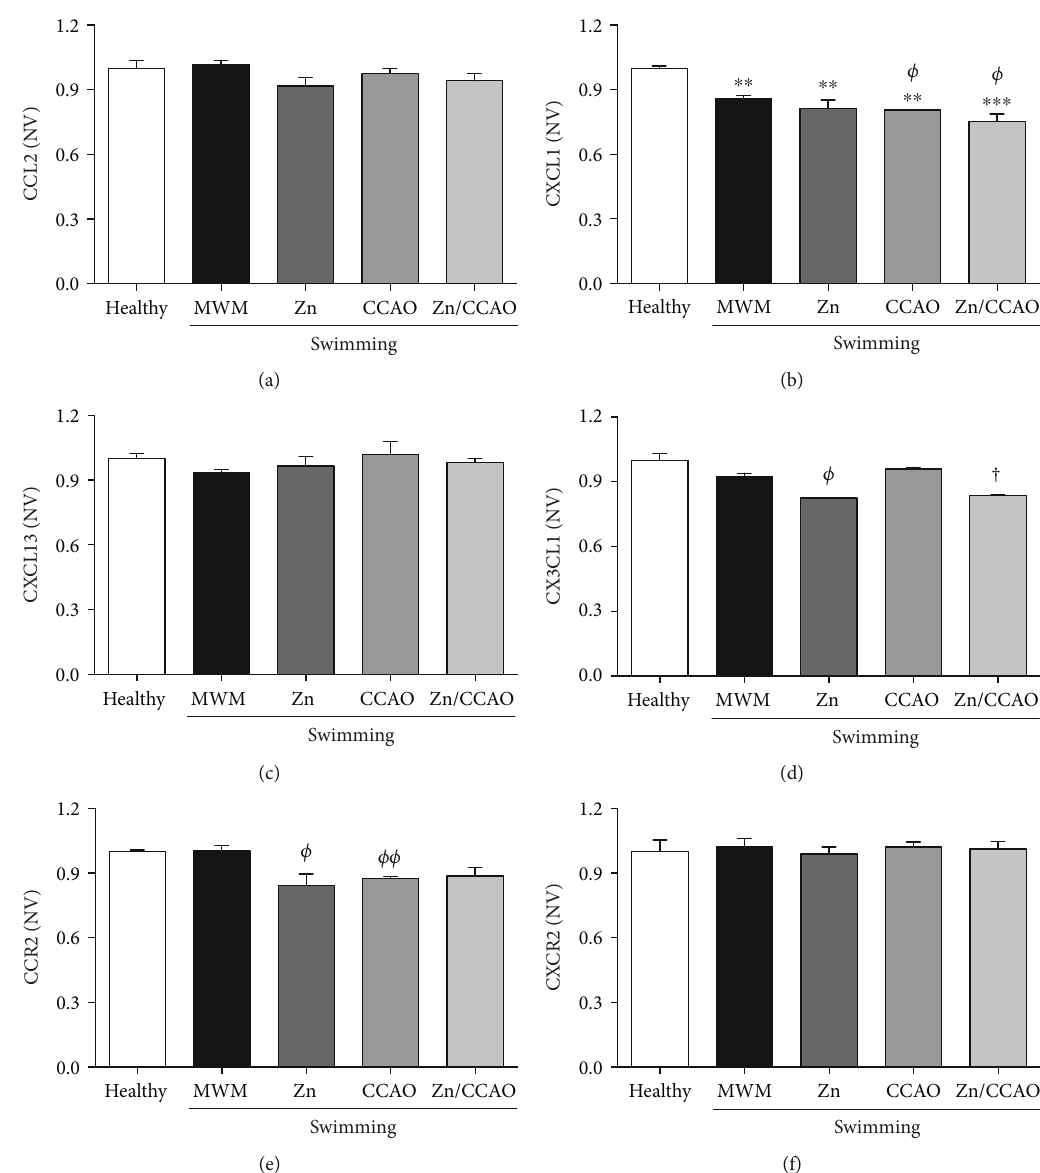
Figure 10: CXCL1, CX3CL1, and CCR2 levels were decreased by treatments compared with the MWM group in the hippocampus on day 12 postreperfusion The values are mean ± SEM ( n = 4 ) and analyzed with one-way ANOVA and Dunnett ’ s post hoc multiple comparisons. P < 0 : 05 , ∗ compared with the healthy group, Φ compared with the MWM group, and † compared with the CCAO group. NV: normalized